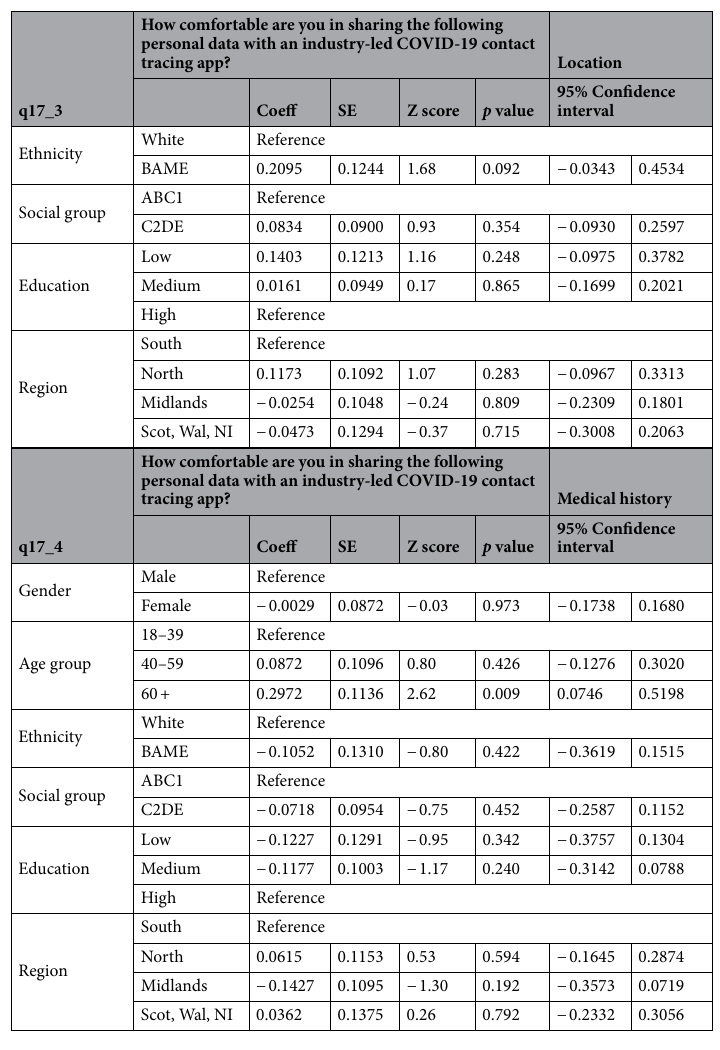
Table 2. Tables demonstrating the results of the multivariate regression analyses for survey